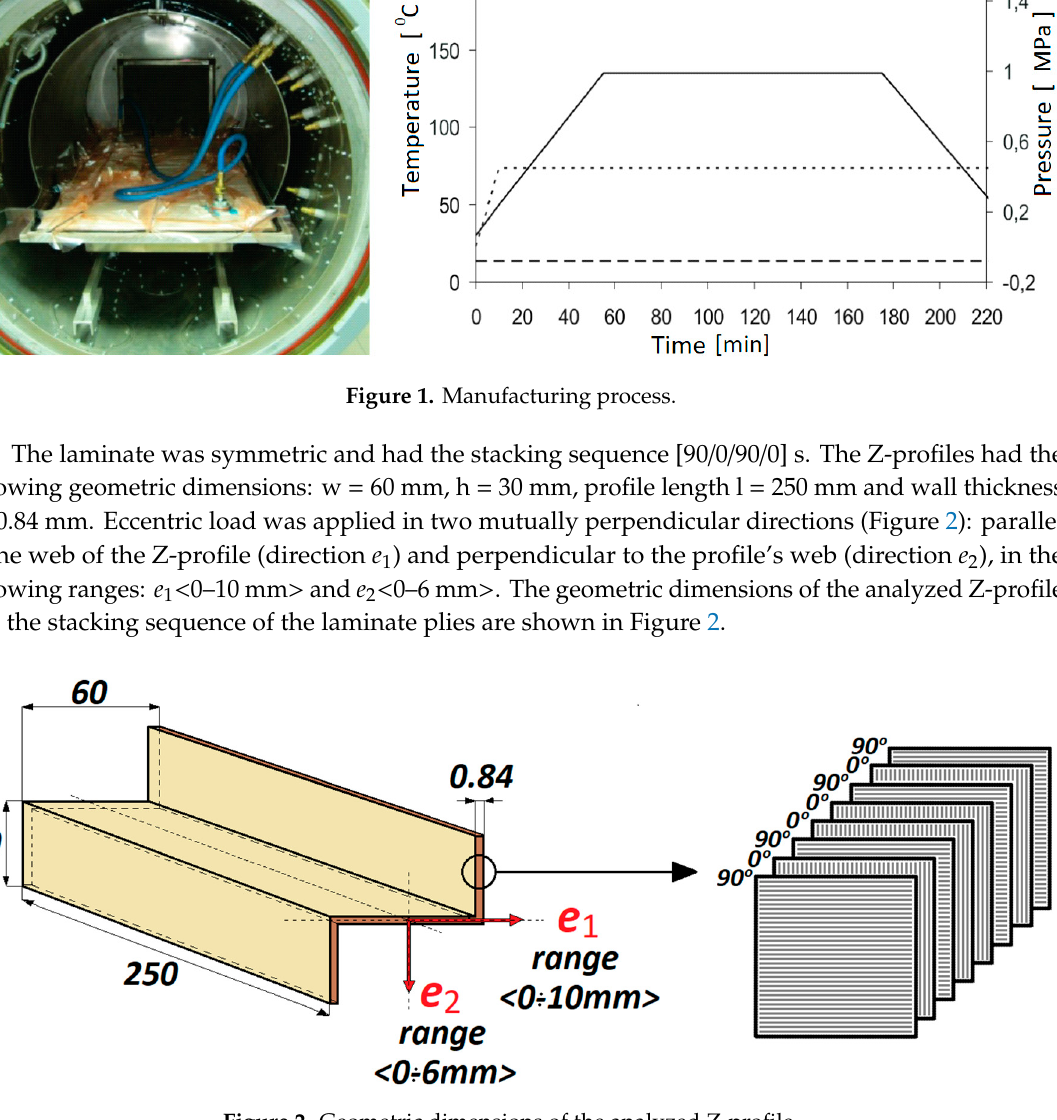
Figure 2. Geometric dimensions of the analyzed Z-profile.